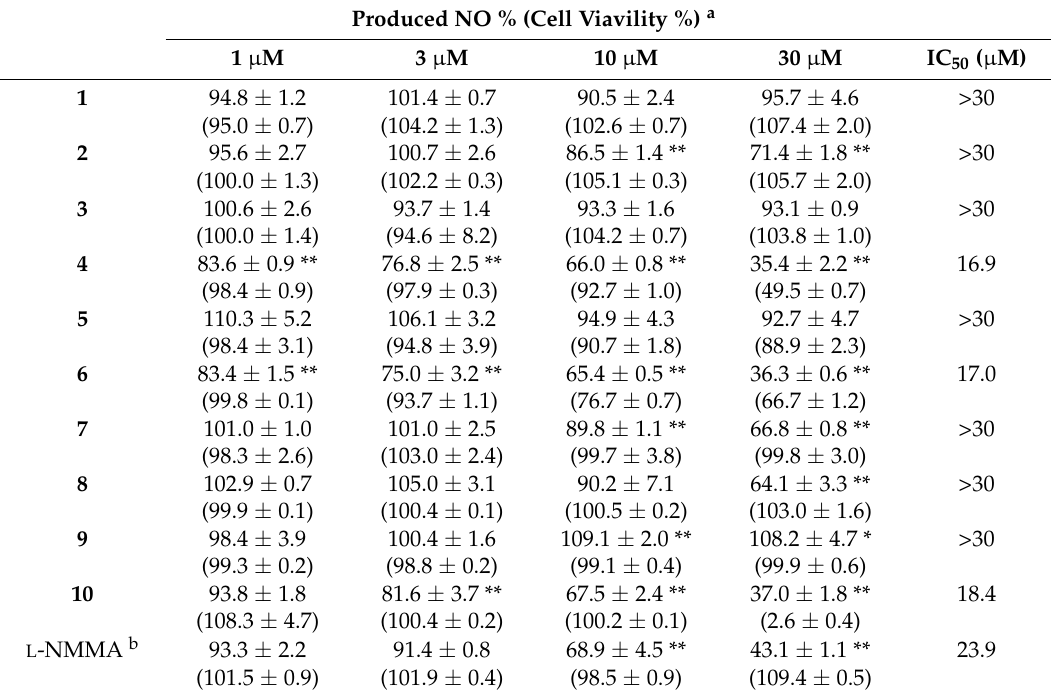
Table 2. Inhibitory effects of NO production by triterpenoids from roots of Taraxacum officinale . Produced NO % (Cell Viavility %)